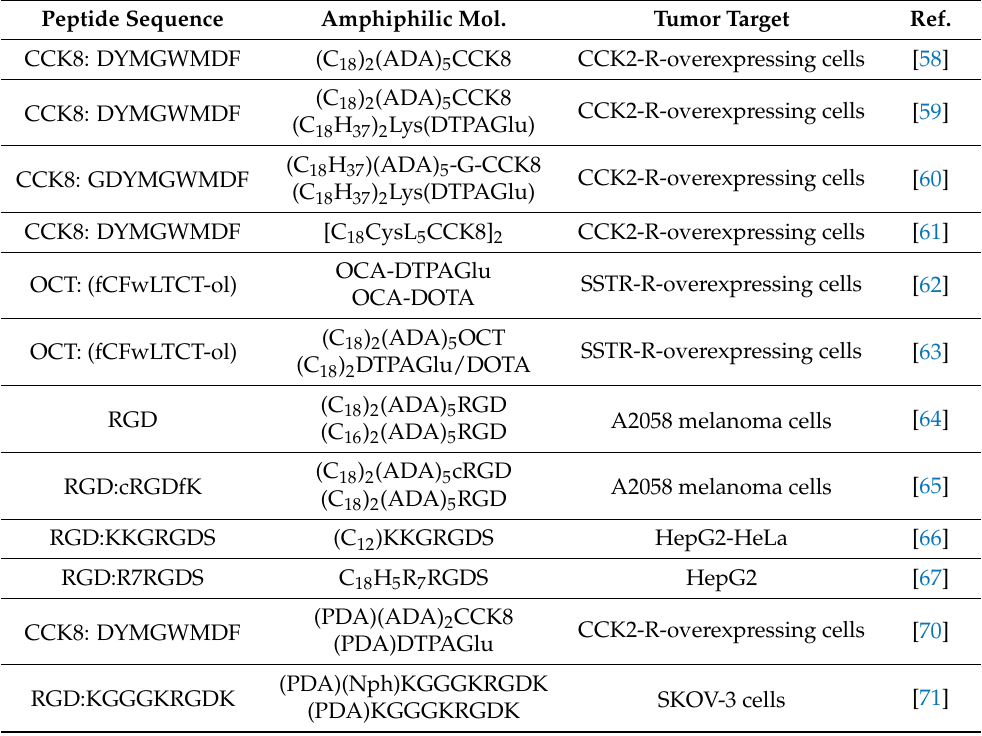
Table 1 reports the peptide surfactant micelles list. Table 1. Peptide surfactant